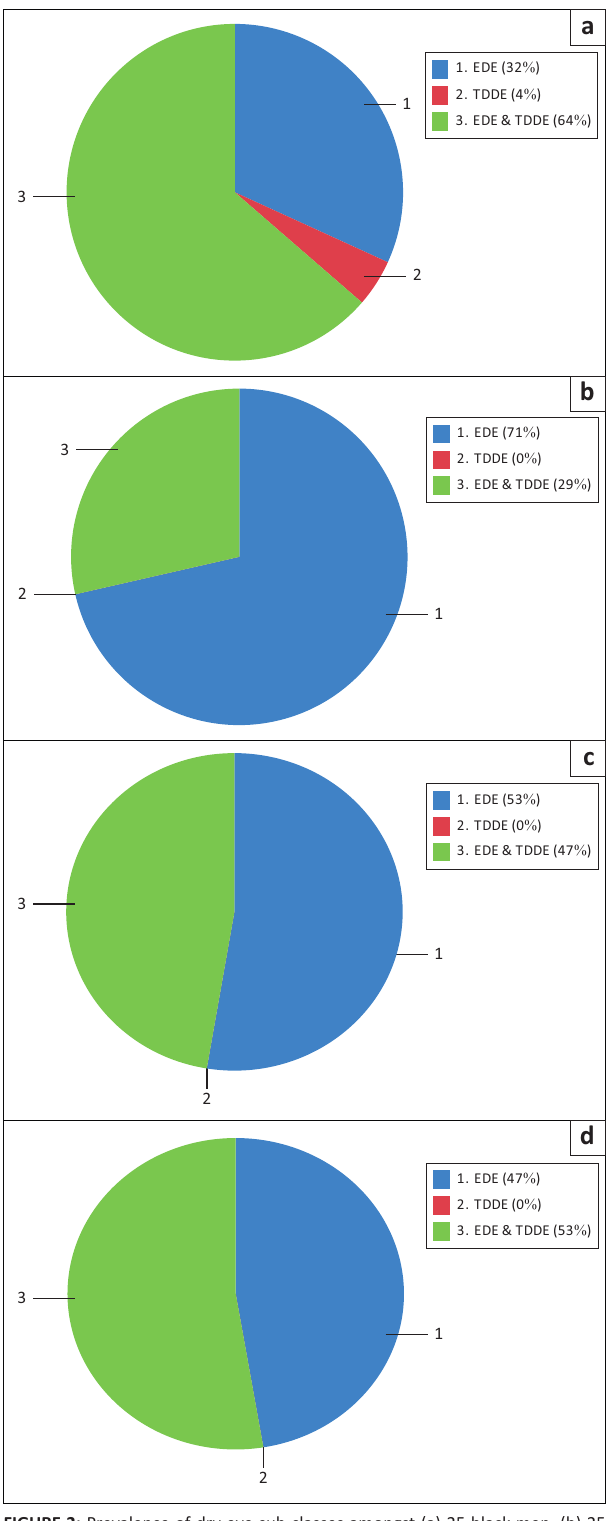
FIGURE 2: Prevalence of dry eye sub-classes amongst (a) 25 black men, (b) 25 Indian men, (c) 25 black women and (d) 25 Indian